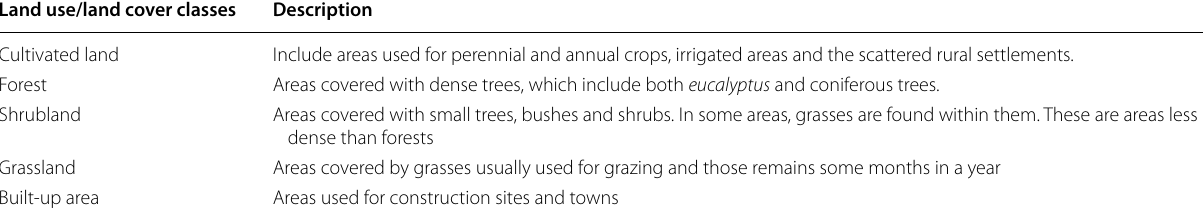
Table 2 Land use/land cover types in the Andassa watershed and their descriptions Land use/land cover